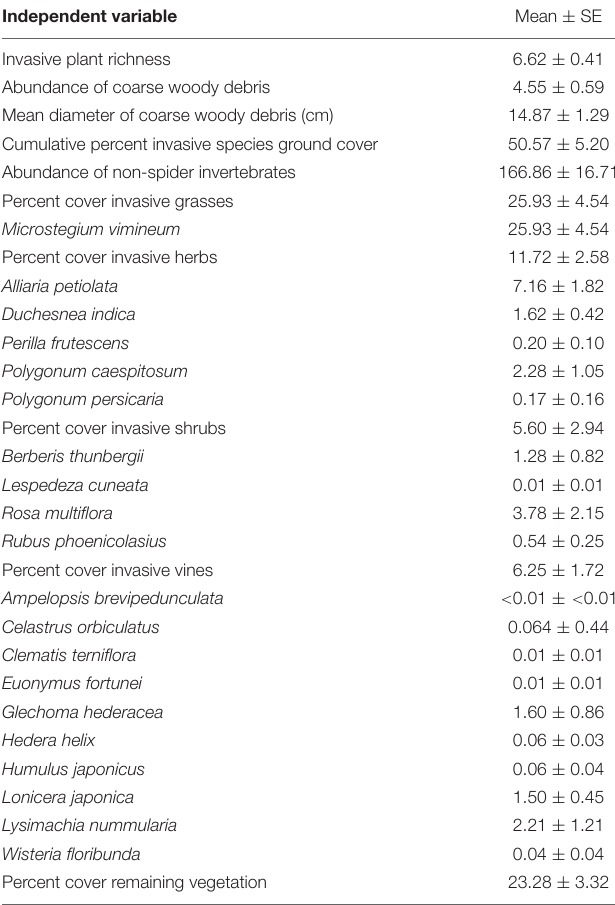
TABLE 1 | Independent variables and mean and SE values identified in sampling plots across the study area in Washington, Frederick, and Montgomery counties, in Maryland, United